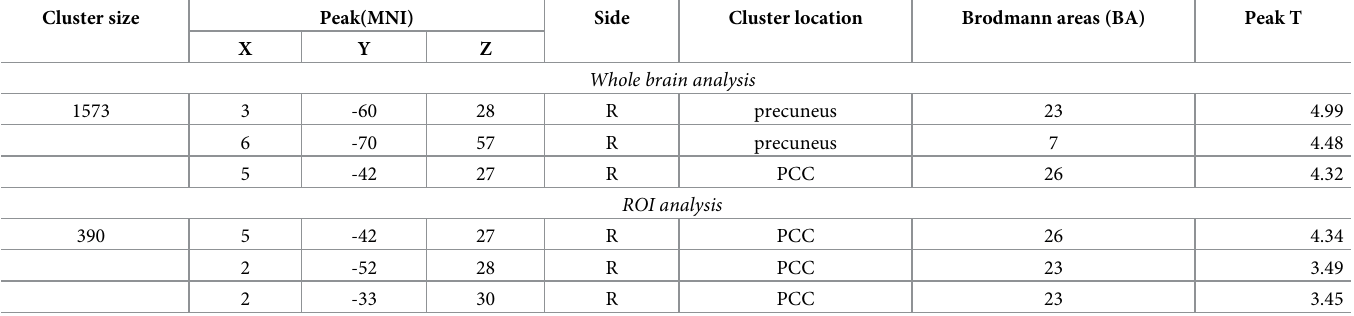
Table 2. Clusters that showed smaller GMV in the CCH group than the control group based on whole brain analysis (FDR correction, p < .001) and ROI analysis (FWE correction, p < .05). Cluster size